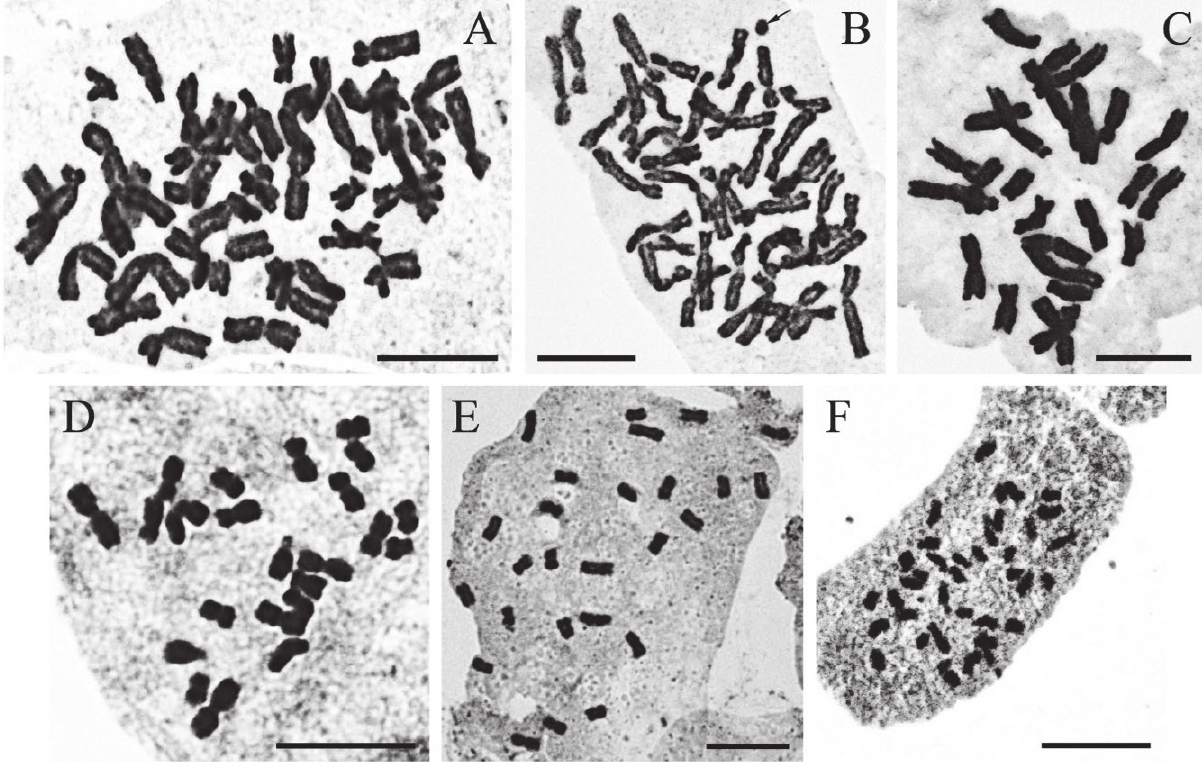
Figure 1. Microphotographs of somatic metaphase plate of Ag. modestum (A) , Ag. simplex (arrow = non chromosome) (B) , Am. serrulatus (C) , Ar. maxwellii (D) , Ha. benthamiana (E) and Ho. griffithii (F) . Scale bars = 10 µ